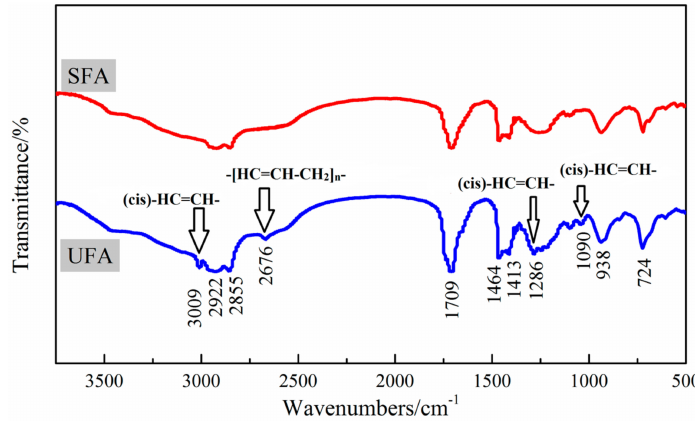
Figure 7. FT-IR spectra of fatty